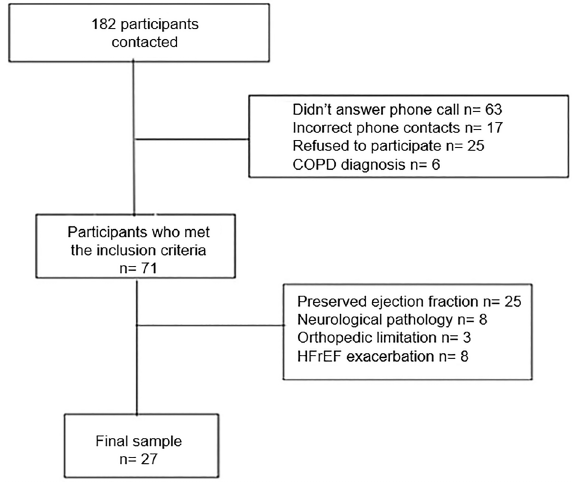
Figure 1. Flowchart of recruited participants. HFrEF: heart failure with reduced ejection fraction; COPD: chronic obstructive pulmo- nary